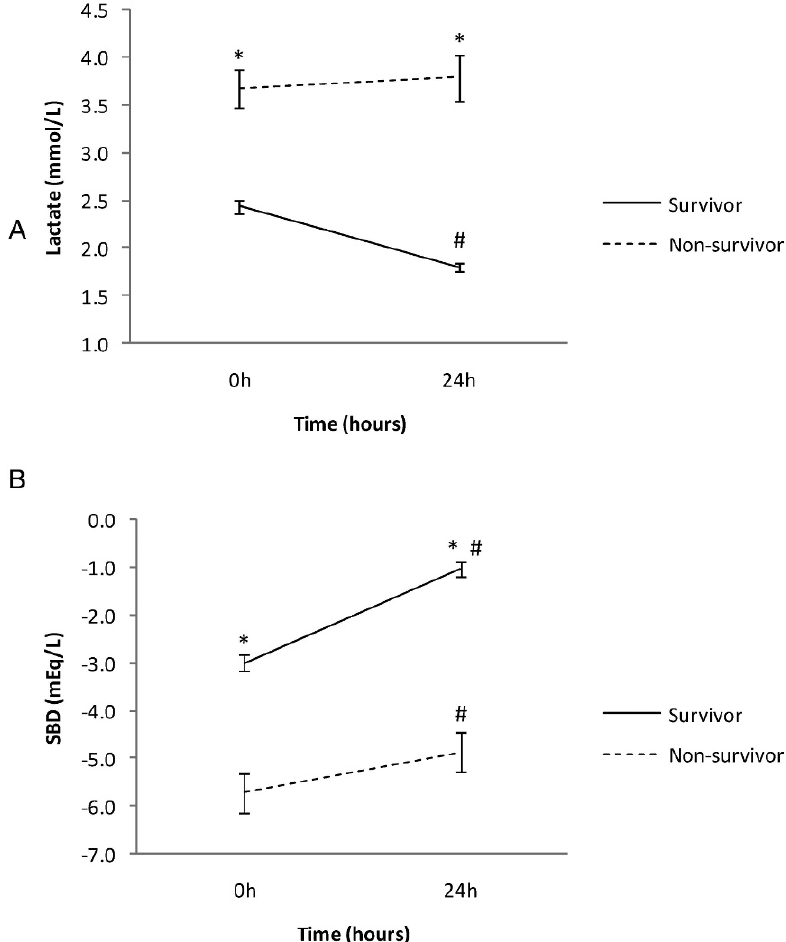
Figure 1 - Comparison between survivor and non-survivor groups of A) lactate (mmol/L) and B) standard base deficit (SBD in mmol/L) in two time points (0 and 24h). Mean + 2 SEM (*) p , 0.05 survivors versus non-survivors ( # ) p ,